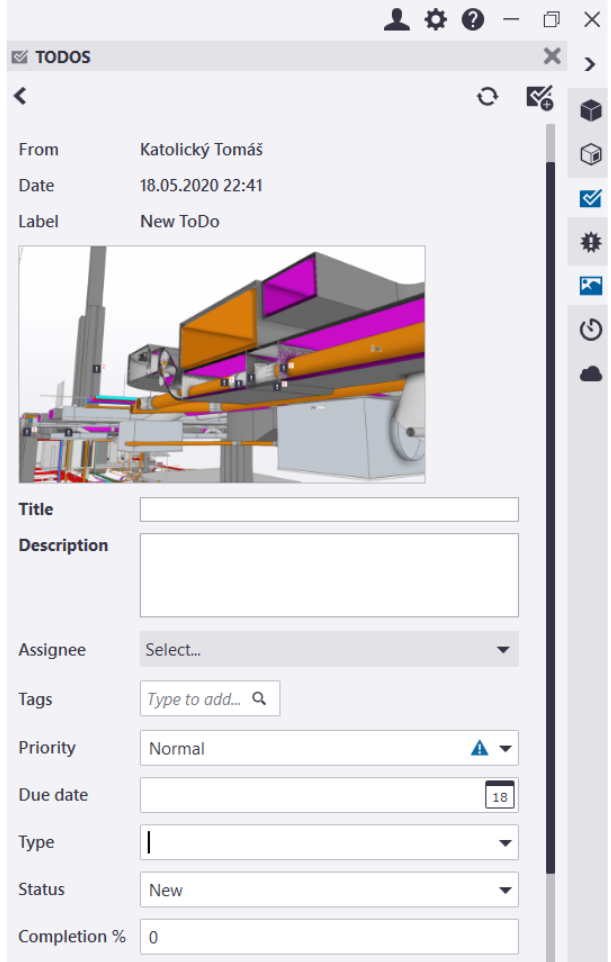
Figure 6: Comments and tasks (ToDos) for the slected clash,